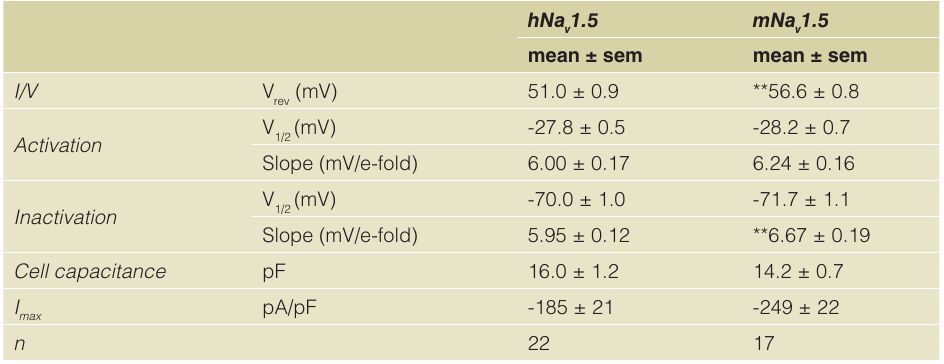
Table 1. Summarized properties of human and mouse Na (I/V)- and steady-state inactivation protocols. Mean values and standard errors are shown. **P<0.01 obtained by two-tailed Student’s t-tests.